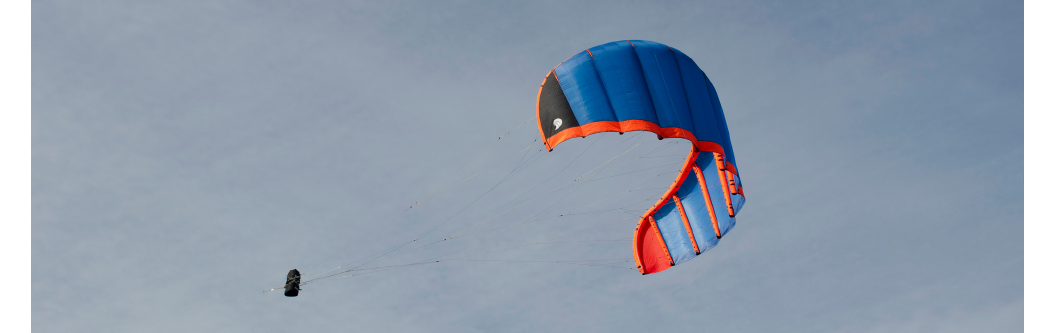
Figure 2. LEI V5.40 kite with 40m 2 wing surface area controlled by a suspended cable robot. This prototype temporarily reached a tether force of 15kN and a mechanical power of 100kW during a test flight in May 2018 (Kitepower B.V., 2018b).